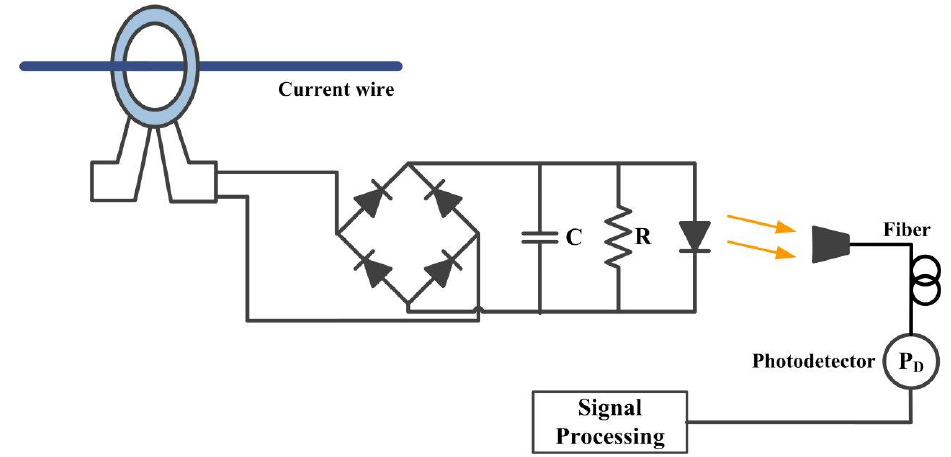
Figure 17. Typical setup of a hybrid sensor